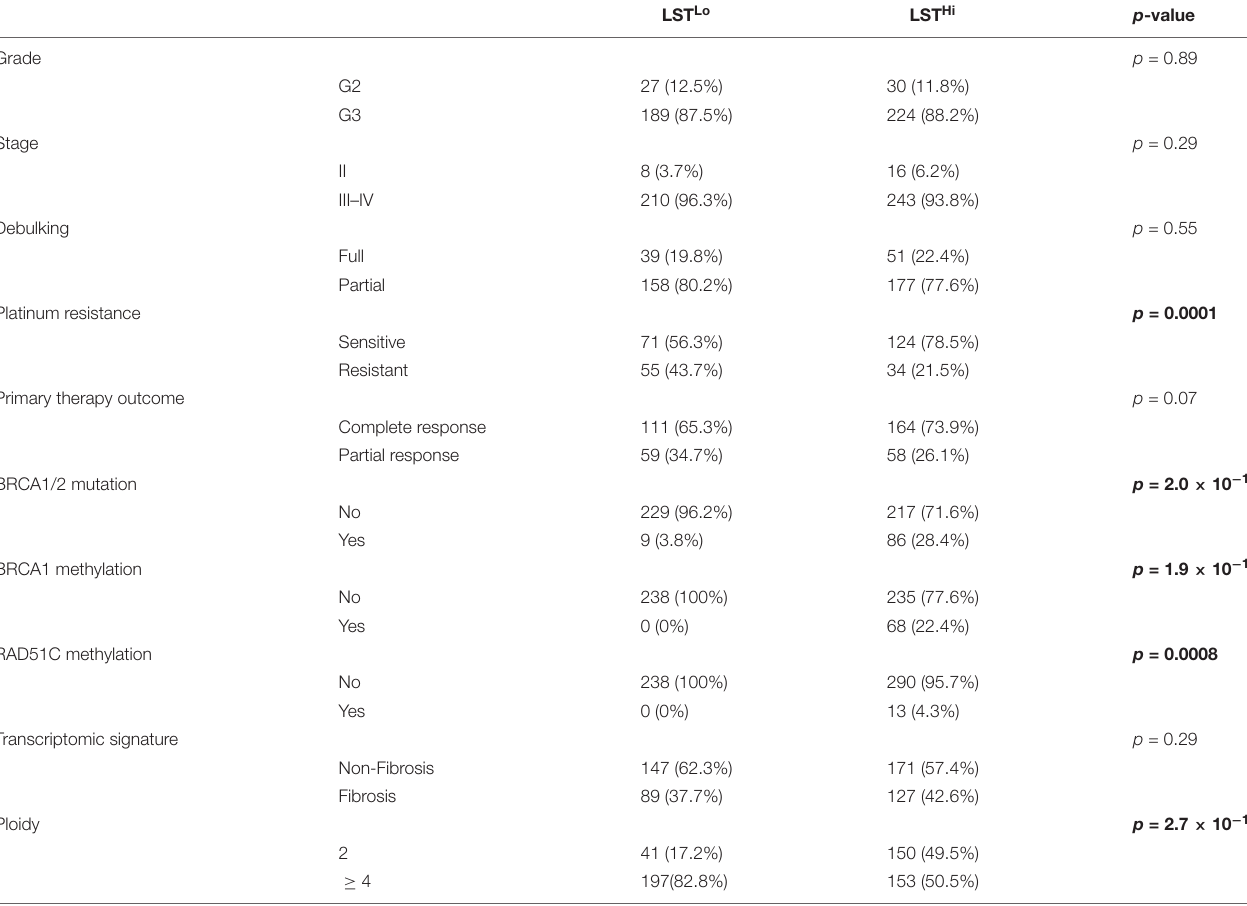
Contingency table showing associations between the LST Lo /LST Hi subgroups and clinical parameters. Debulking status and response to primary therapy were defined as in Table 2 . These analyses were performed on the TCGA cohort. P-values were calculated using Fisher’s exact test and significant p-values are indicated in